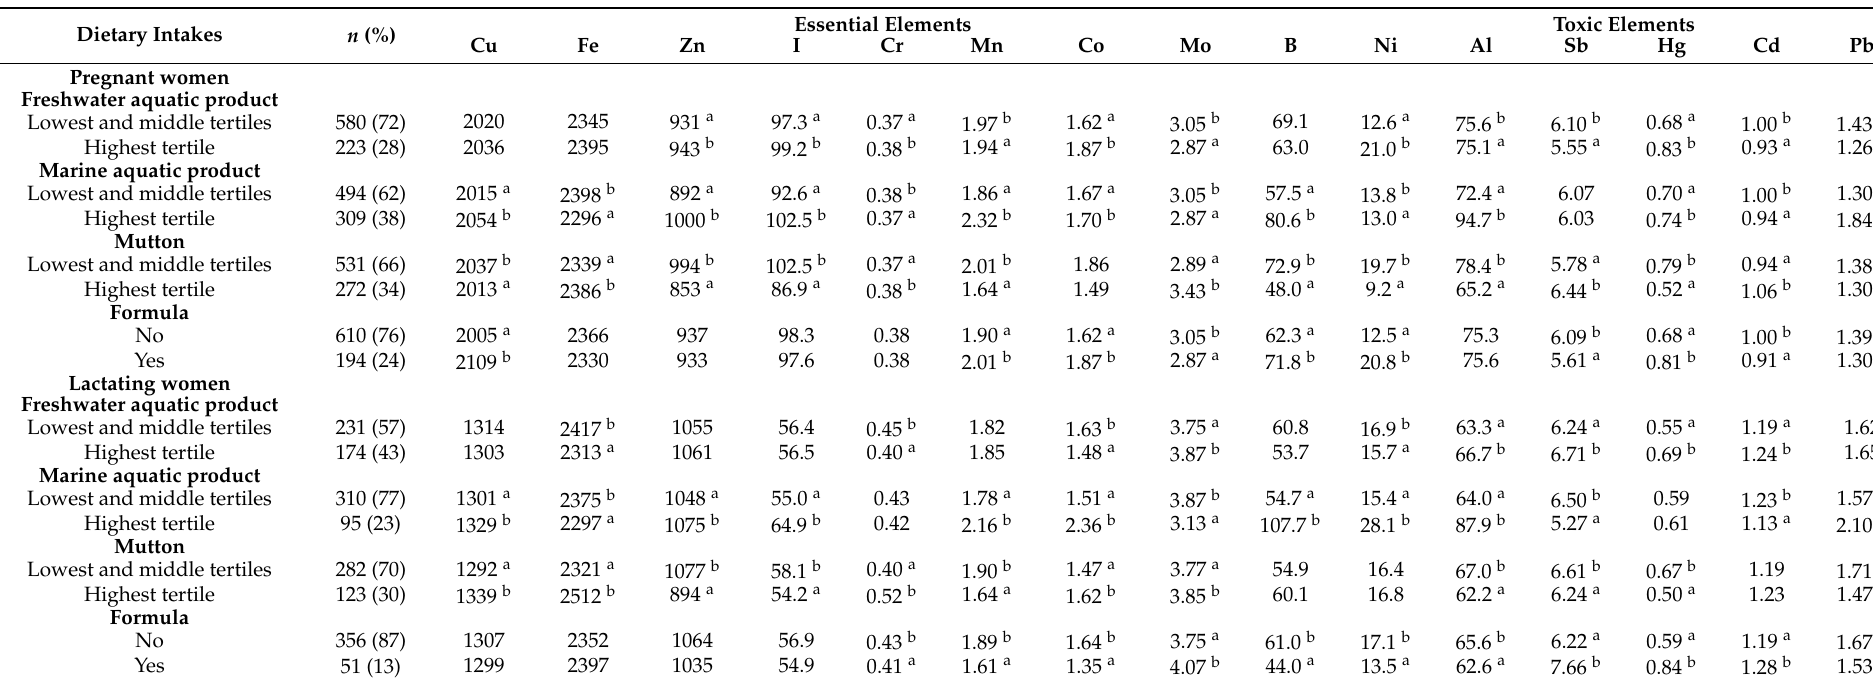
Table 4. Adjusted median concentrations (ng/mL) of plasma essential and toxic elements by dietary intakes of pregnant and lactating women ( n = 1208) 1